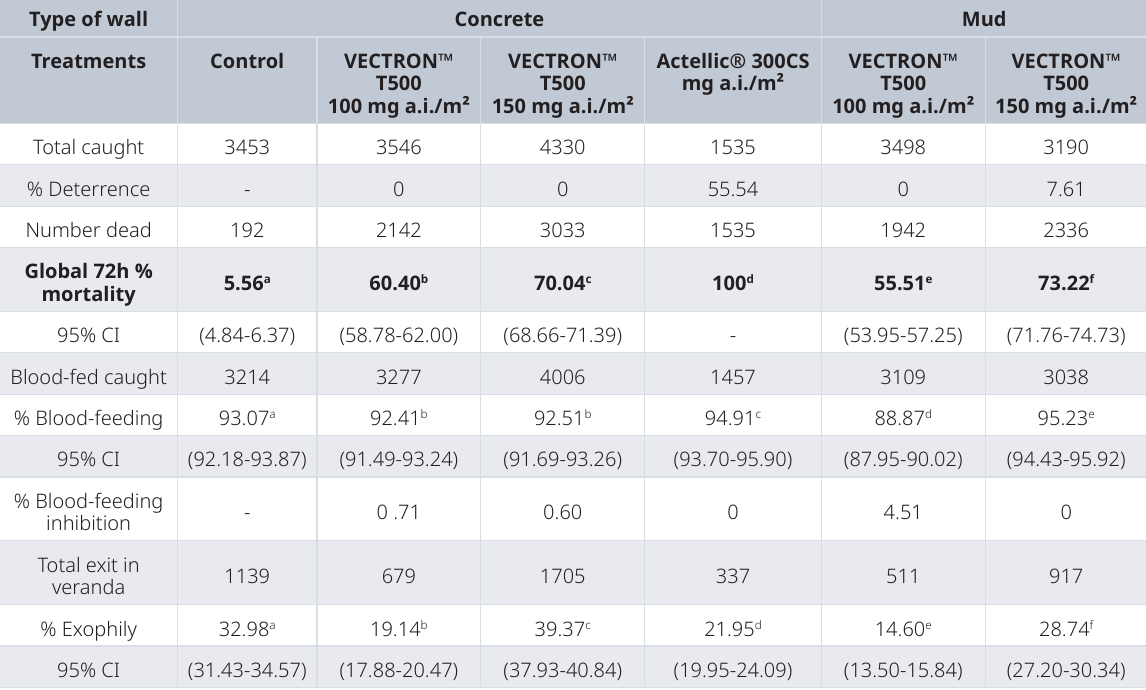
Table 3. Overall mortality 72h after collection, deterrence, blood-feeding rates and exophily induced by treatments on free flying Anopheles gambiae s.l. collected in treated huts during 12 consecutive weeks evaluation. Type of